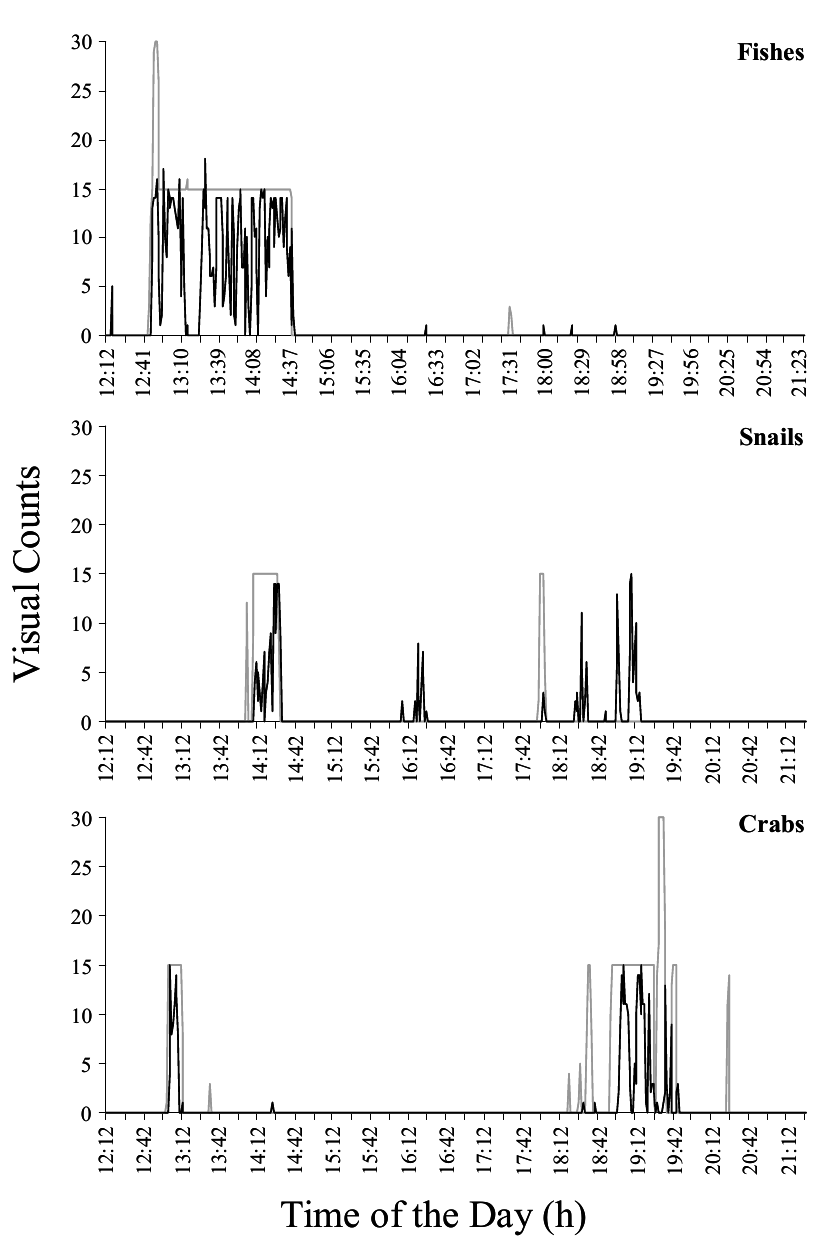
Figure 4. Time series of visual counts per minute as estimated by automated video-image analysis (black line) and by manual classification from the trained operator (grey line) are presented in order to account for the reliability of applied